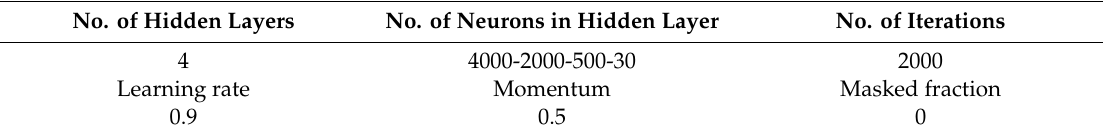
Table 3. Detailed information of SAE.